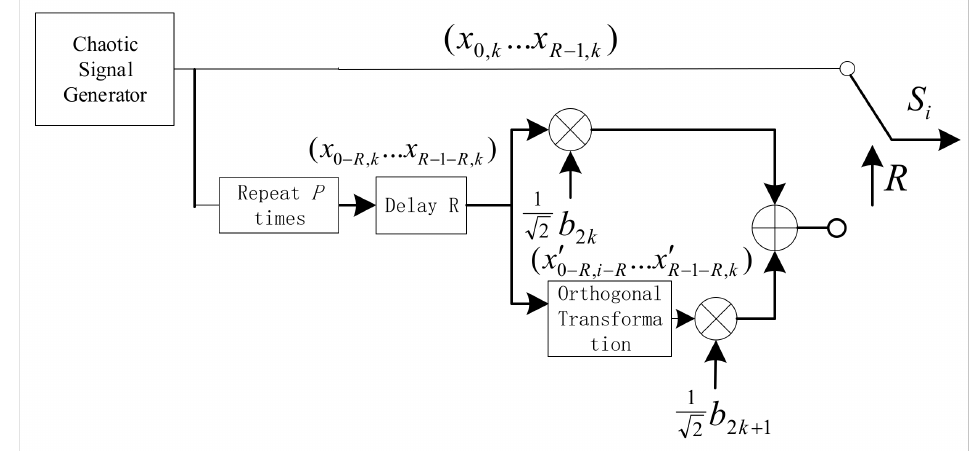
Figure 4. Modulation structure diagram of the